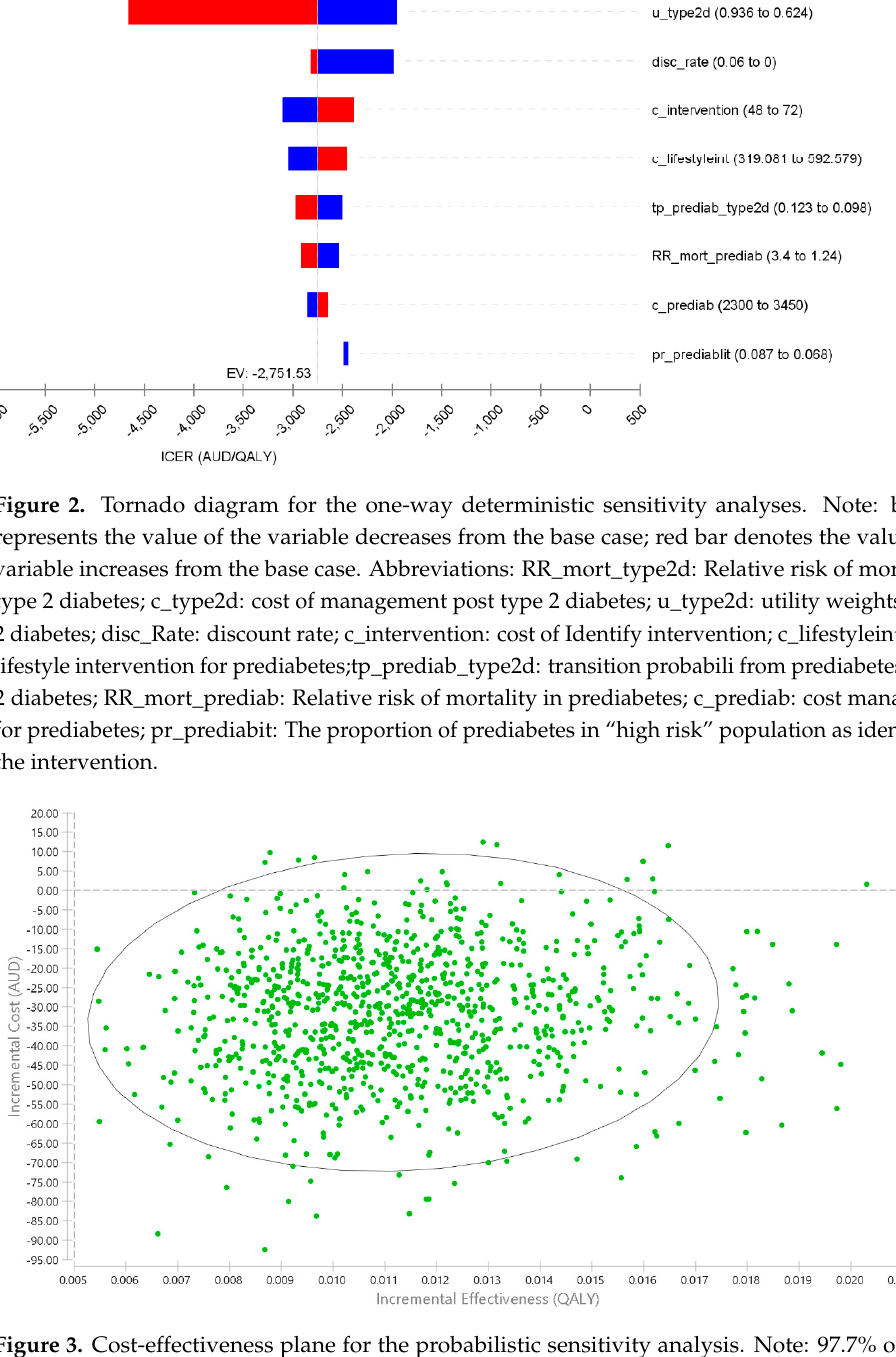
Figure 3. Cost-effectiveness plane for the probabilistic sensitivity analysis. Note: 97.7% of results indicating iDENTify is less costly and more effective. The remaining 2.3% of iterations were cost- effective, but not cost-saving. So there is no red dots to show the cost-ineffective results. The eclipse represents the 95% confidence interval of the